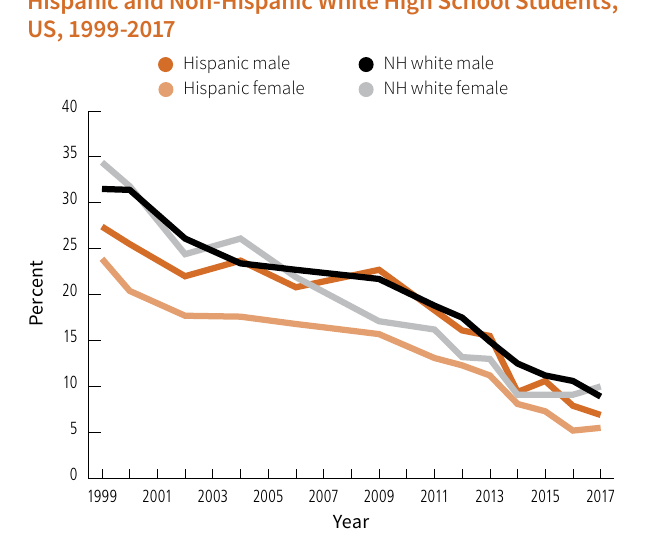
Figure 8. Current Cigarette Smoking* (%) Trends, Hispanic and Non-Hispanic White High School Students,